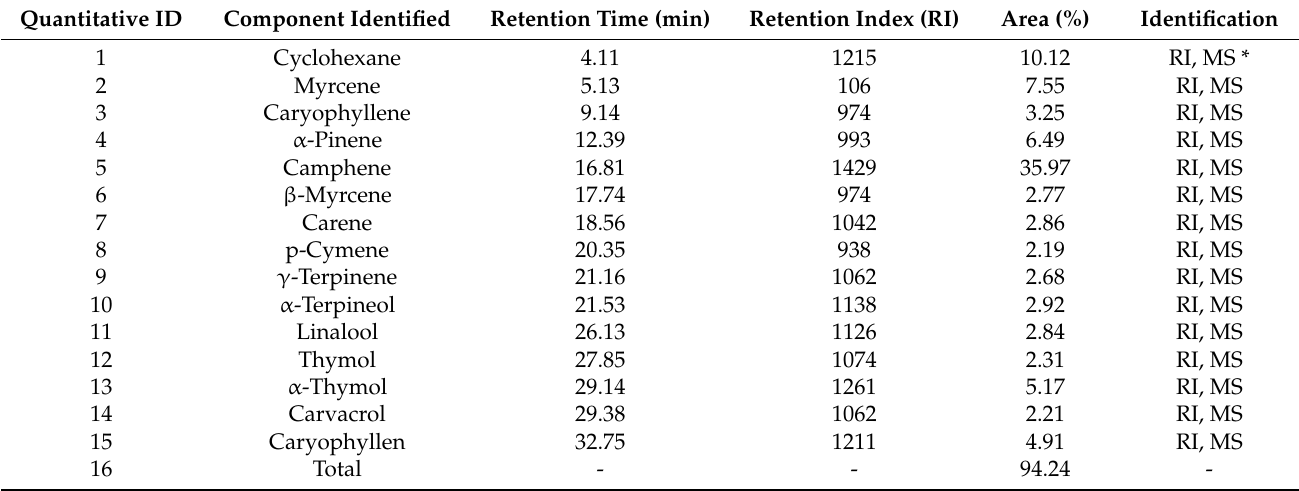
Table 1. The list of main constituents present in T. vulgaris EO using GC-MS analysis.